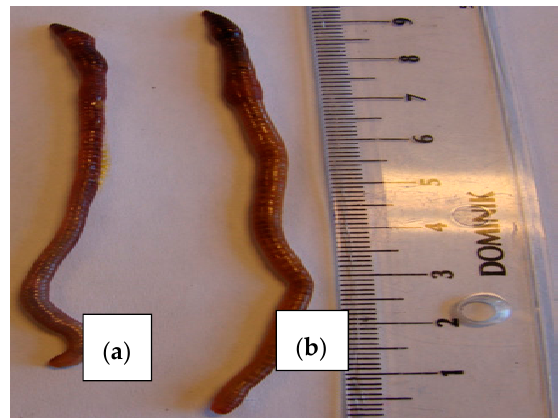
Figure 8. Mature E. fetida individuals used in the experiment: ( a ) control, ( b ) Owinema.